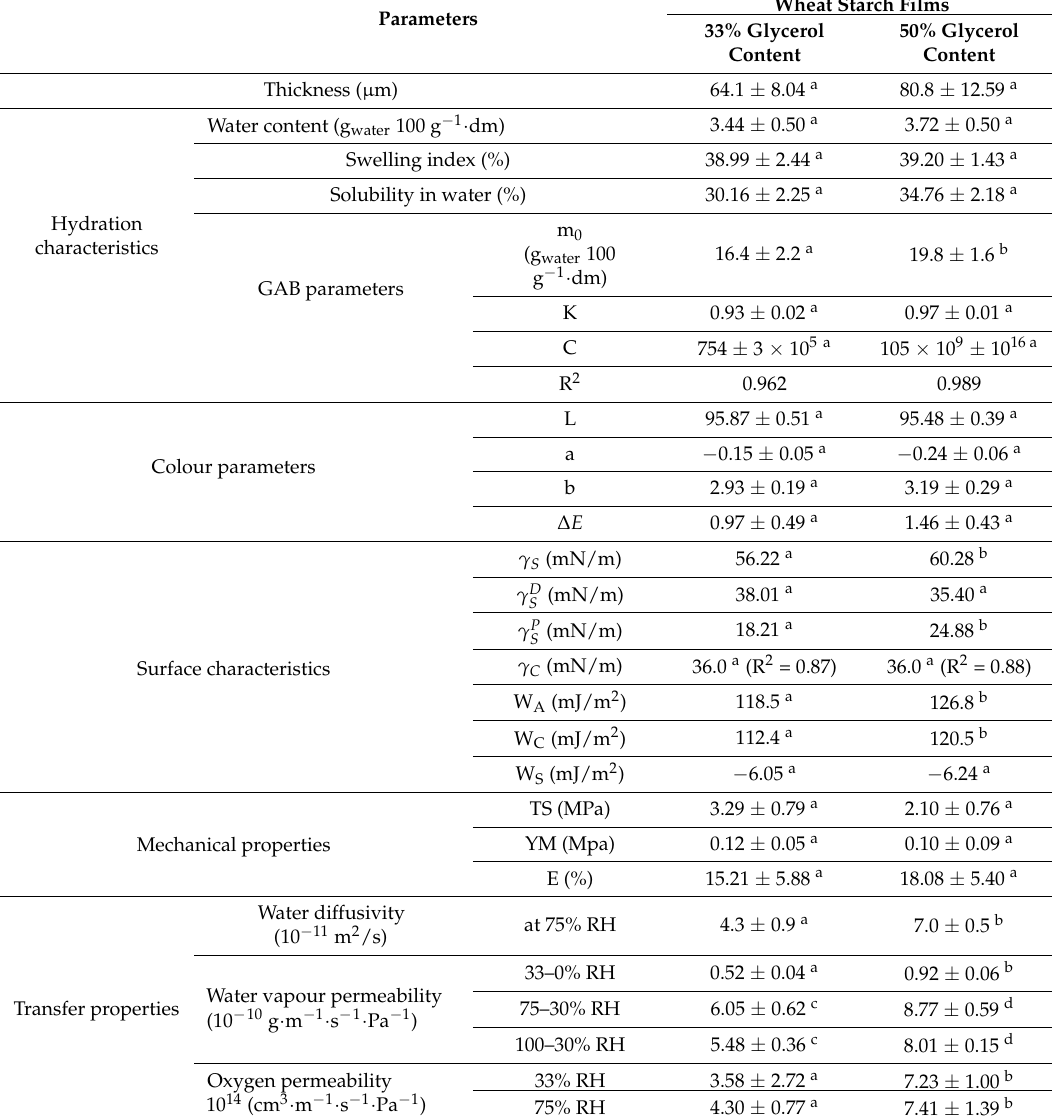
Table 1. Water content, swelling index, film solubility in water, parameters of the GAB equation (m 0 , K, C), color parameters (L, a, b, ∆ E), surface tension ( γ c ), dispersive ( γ D the surface tension, critical surface tension ( γ C ), works of adhesion (W A ), of cohesion (W C ) and of spreading (W S ), tensile strength (TS), Yong modulus (YM), elongation at break (E), water vapor and oxygen permeabilities of wheat starch films containing 33% or 50%